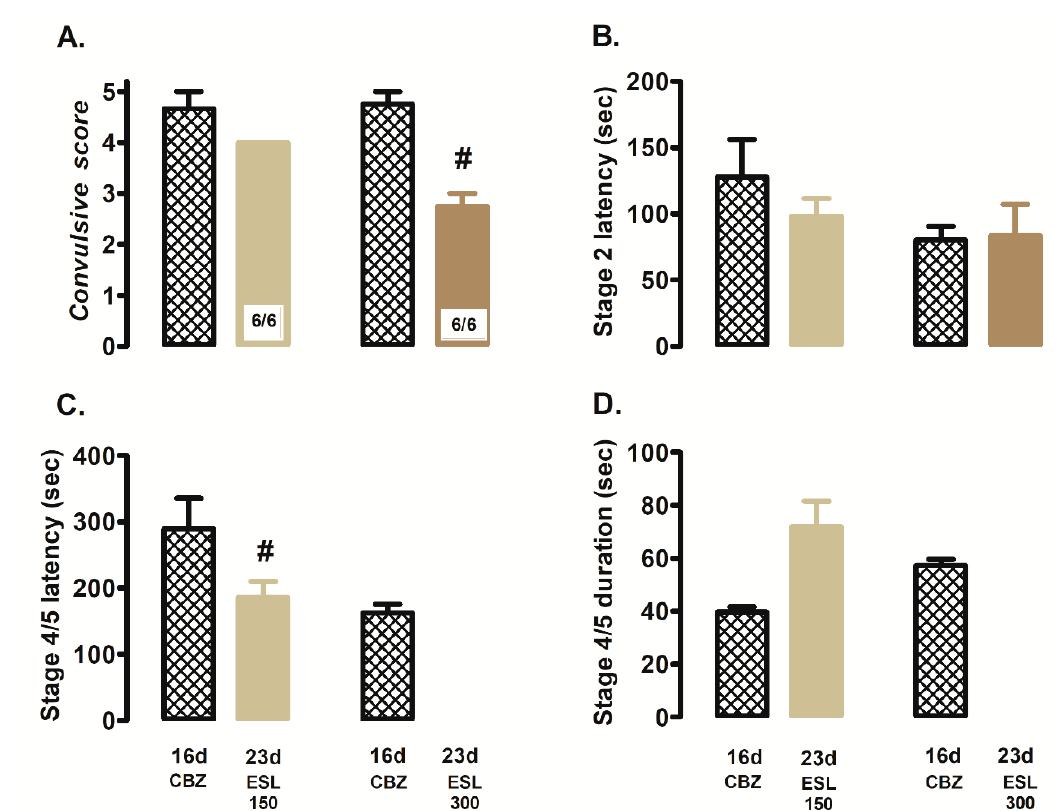
Figure 3. Effects of eslicarbazepine (23 d; ESL, 150 or 300 mg/kg i.p.) on convulsive score ( A ), stage